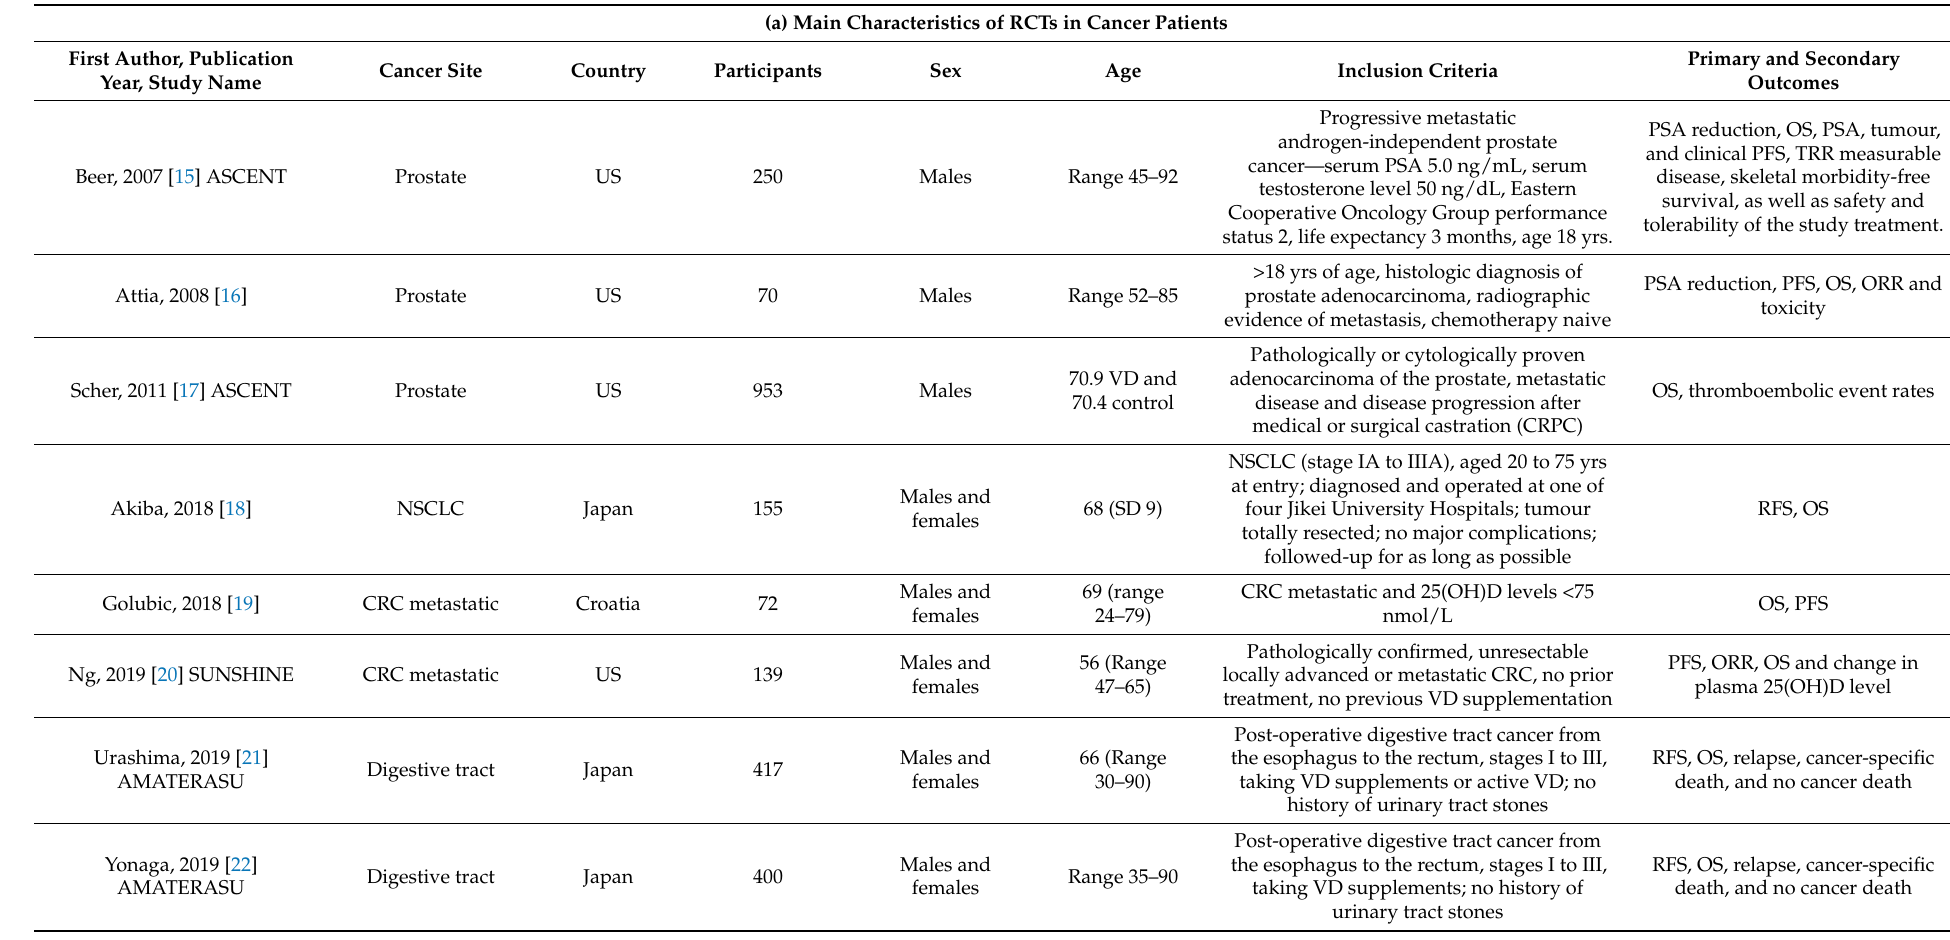
Table 1. Main characteristics of included studies ( n . 25 articles: n . 8 RCT on cancer patients, n. 8 population RCT, n . 9 observational